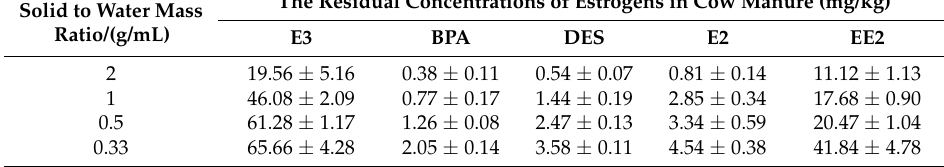
Table 4. Effect of the solid to water mass ratio on the residual concentrations of estrogens in cow manure by the Fenton oxidation process. Note: the Fe(II) to H 2 O 2 molar ratio was 0.10 M/M; the H 2 O 2 dosage was 2.56 mmol/g; the initial pH values was 3.0; the reaction time was 24 h. The Residual Concentrations of Estrogens in Cow Manure Solid to Water Mass Ratio/(g/mL)